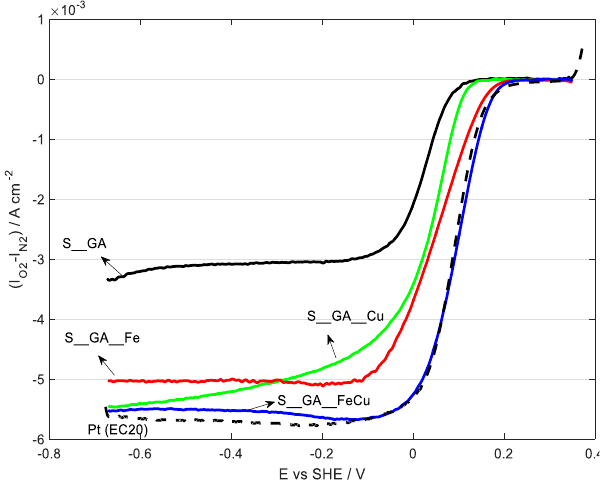
Figure 7. Oxygen reduction reaction (ORR) polarization curves recorded in oxygen-saturated 0.1 M KOH, v = 5 mV s − 1 , ω = 1600 rpm, T = 25 °C. Table 4. ORR Onset E onset (at j = 1 mA cm − 2 ), Half Wave Potentials E 1/2 , and Exchanged Electrons Number n e − .